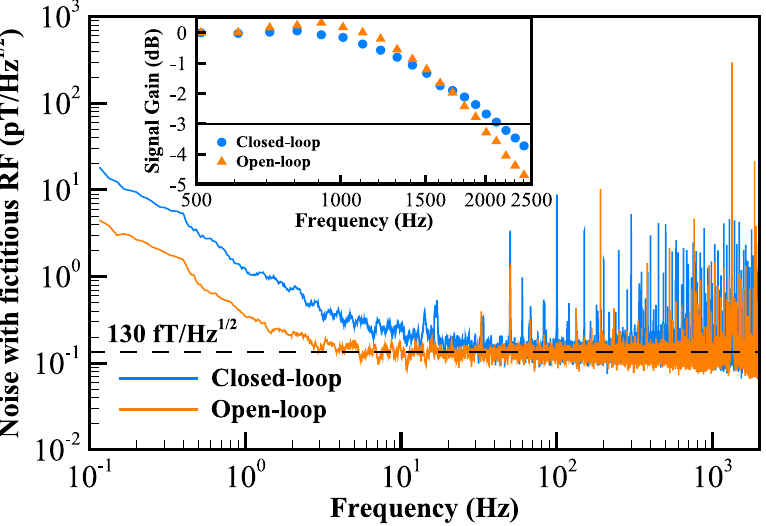
Figure 5. Spectral densities of the magnetic-field noise in open-loop (orange plot) and closed-loop (blue plot) operations of fictitious RF scheme. The sensitivities are approximately 130 fT/Hz 1/2 for both modes. The closed-loop noise floor approaches that of the open-loop noise at frequencies above 40 Hz. The inset shows the signal frequency responses, demonstrating a measurement bandwidth of approximately 2